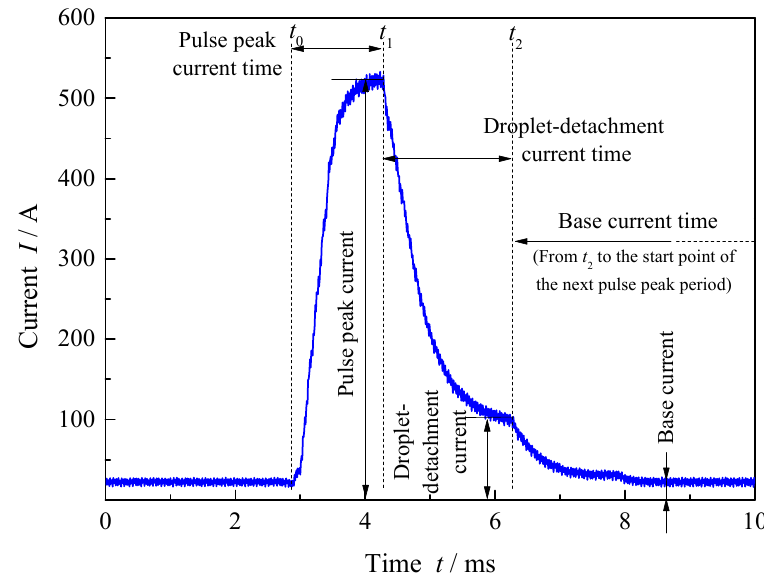
Figure 2. Main parameters of pulse current waveform.